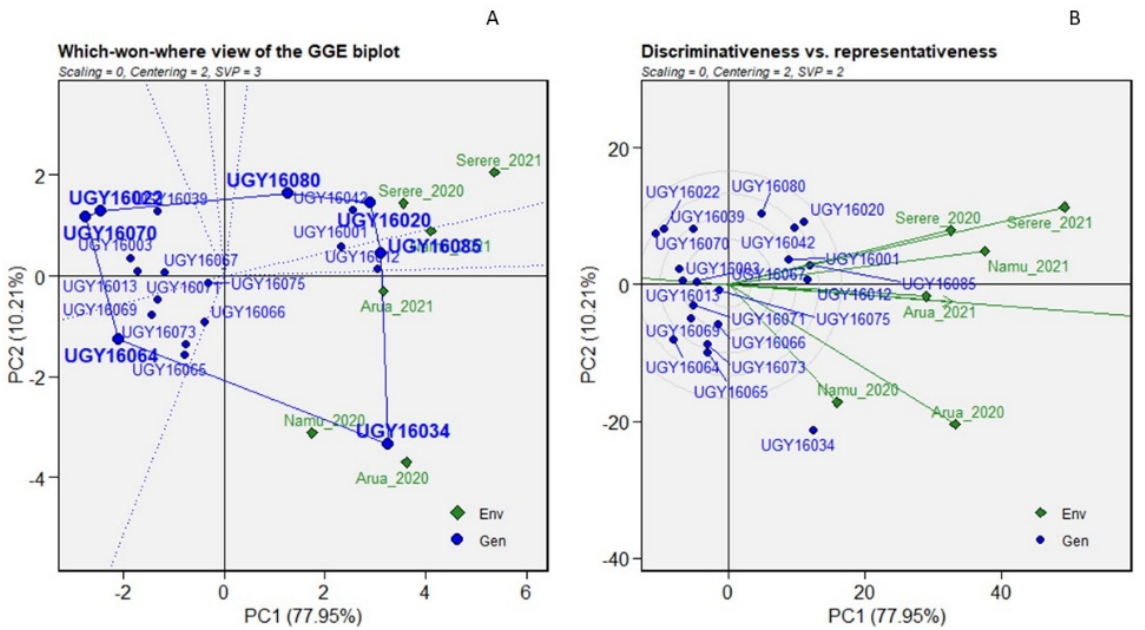
Figure 7. GGE biplots based on symmetrical scaling for ( A ) the “which ‐ won ‐ where” pattern and ( B ) the discriminating power and representativeness of test environments, involving 20 yam genotypes for total yield of yams (kg/plot) evaluated in six environments.